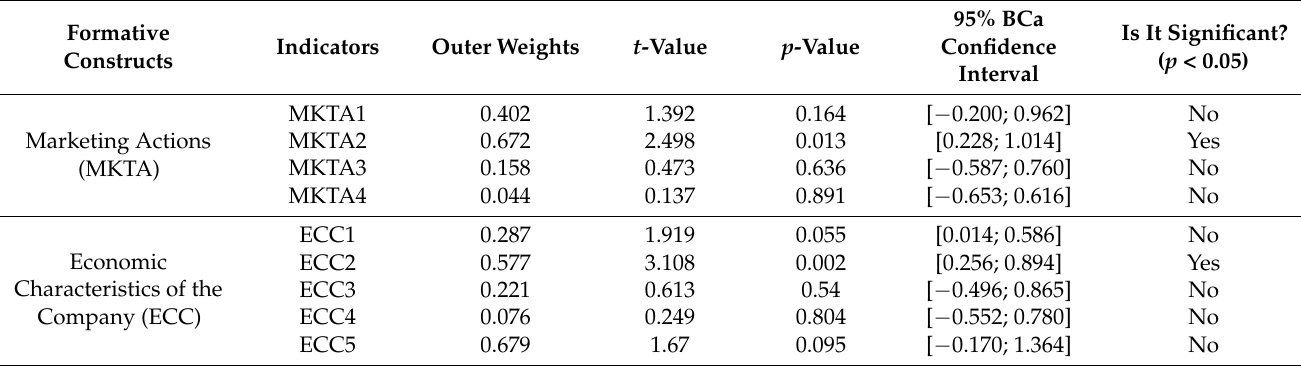
Table 6. Significance and relevance of outer